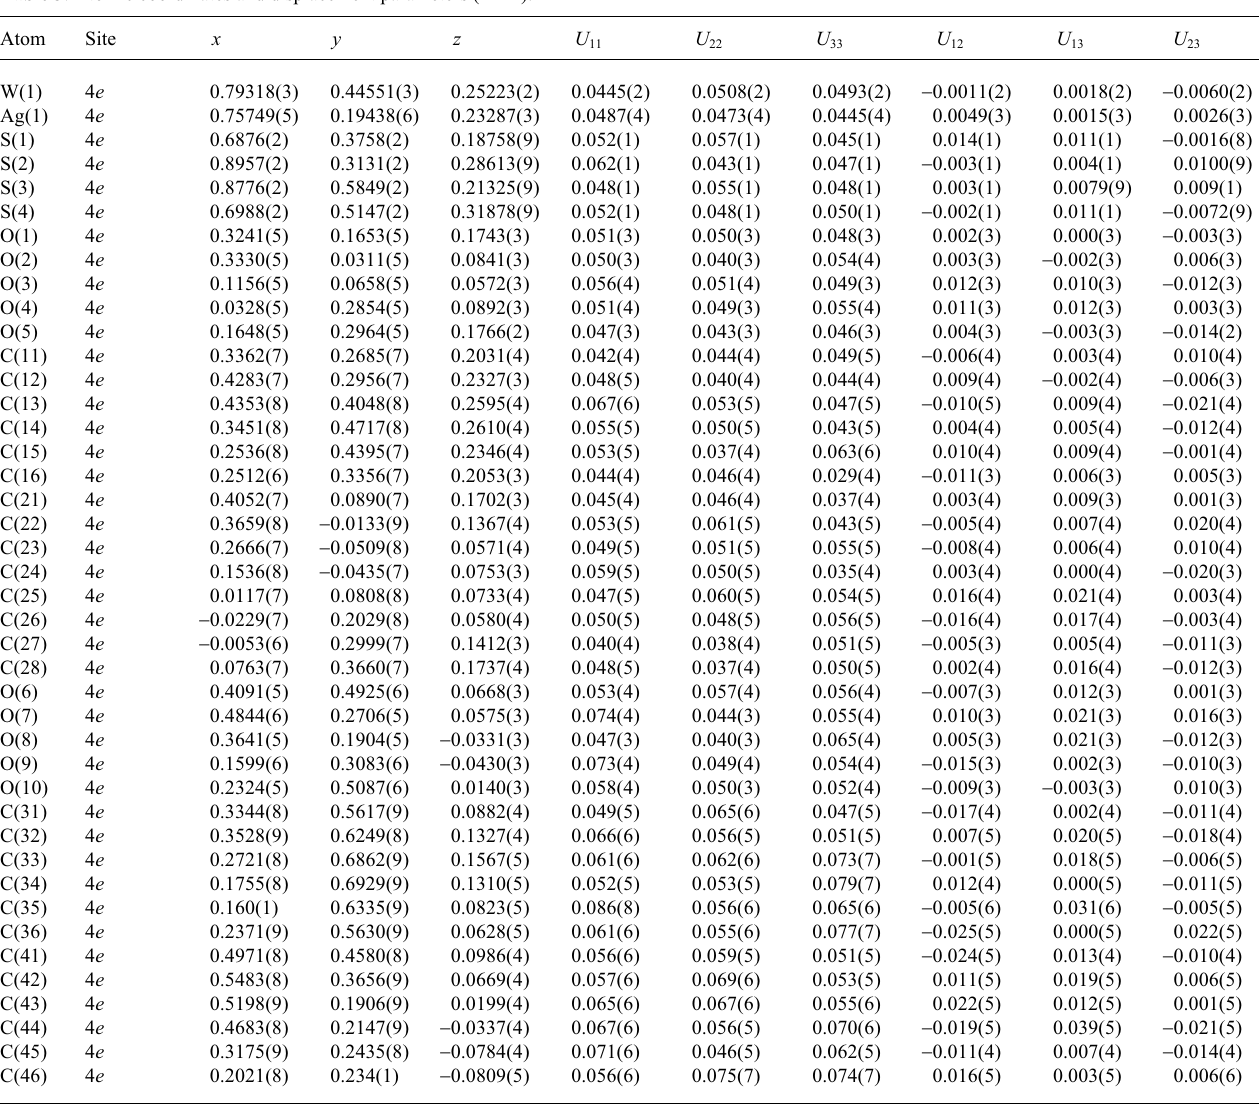
Table 3. Atomic coordinates and displacement parameters (in Å 2 ).